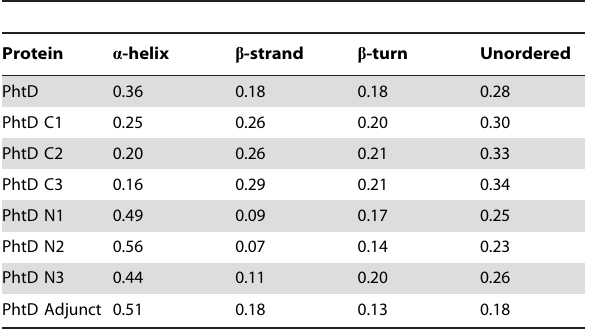
Table 2. Circular dichroism spectroscopy analysis of PhtD and truncated derivatives.